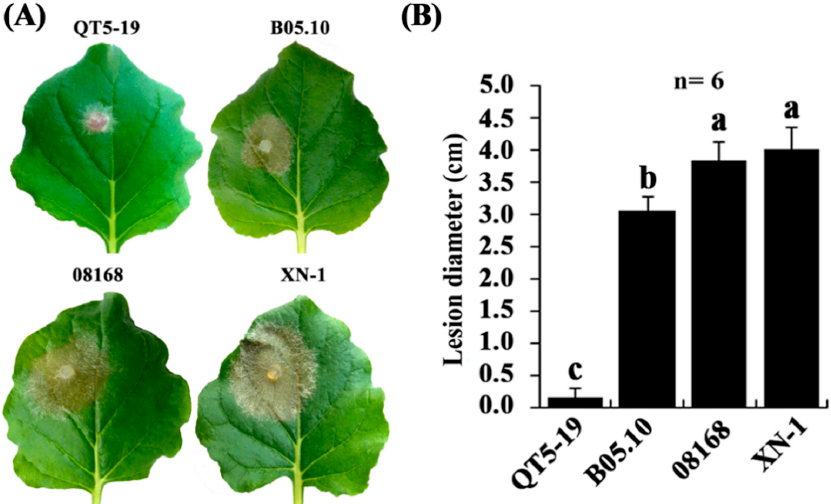
Figure 2. Pathogenicity of Botrytis cinerea isolates on tobacco ( Nicotiana benthamiana ). ( A ) Four tobacco leaves inoculated with the mycelia of the isolates QT5-19, 08168, B05.10, and XN-1, respectively (20 °C, 3 dpi). Note no visible lesion formation on the leaf inoculated with isolate QT5-19, whereas formation of large necrotic lesions on the leaves inoculated with the other three isolates; ( B ) A histogram showing average leaf lesion diameters caused by the four isolates. Means ± S.D. ( n = 6) labeled with the same letters are not significantly different at p > 0.05.